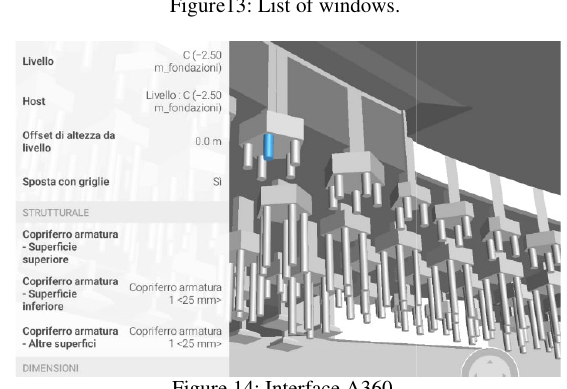
Figure 14: Interface A360.